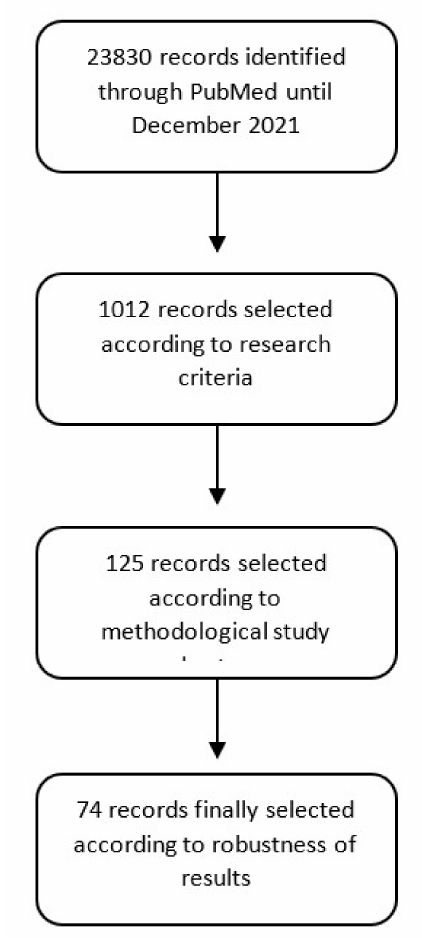
Figure 1. Literature search